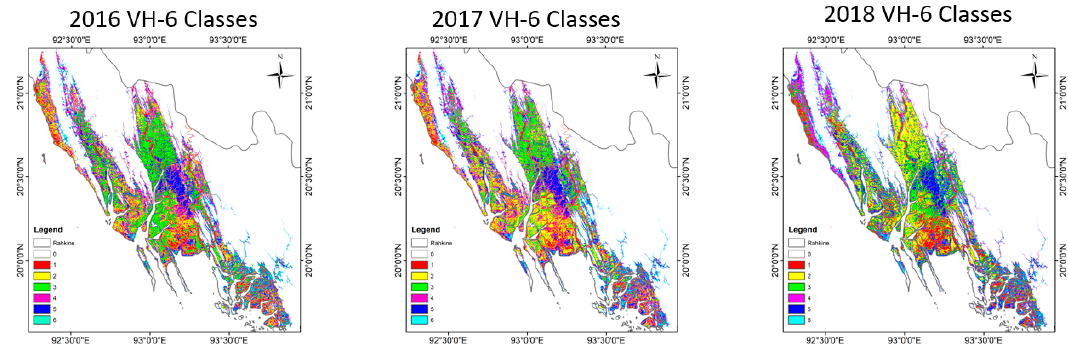
Figure 4. General land use—land cover classes were created using simple K-means clustering of time series Sentinel-1 VH to help mask out non-cropland areas and focus further time series analysis on arable landscape pixels.